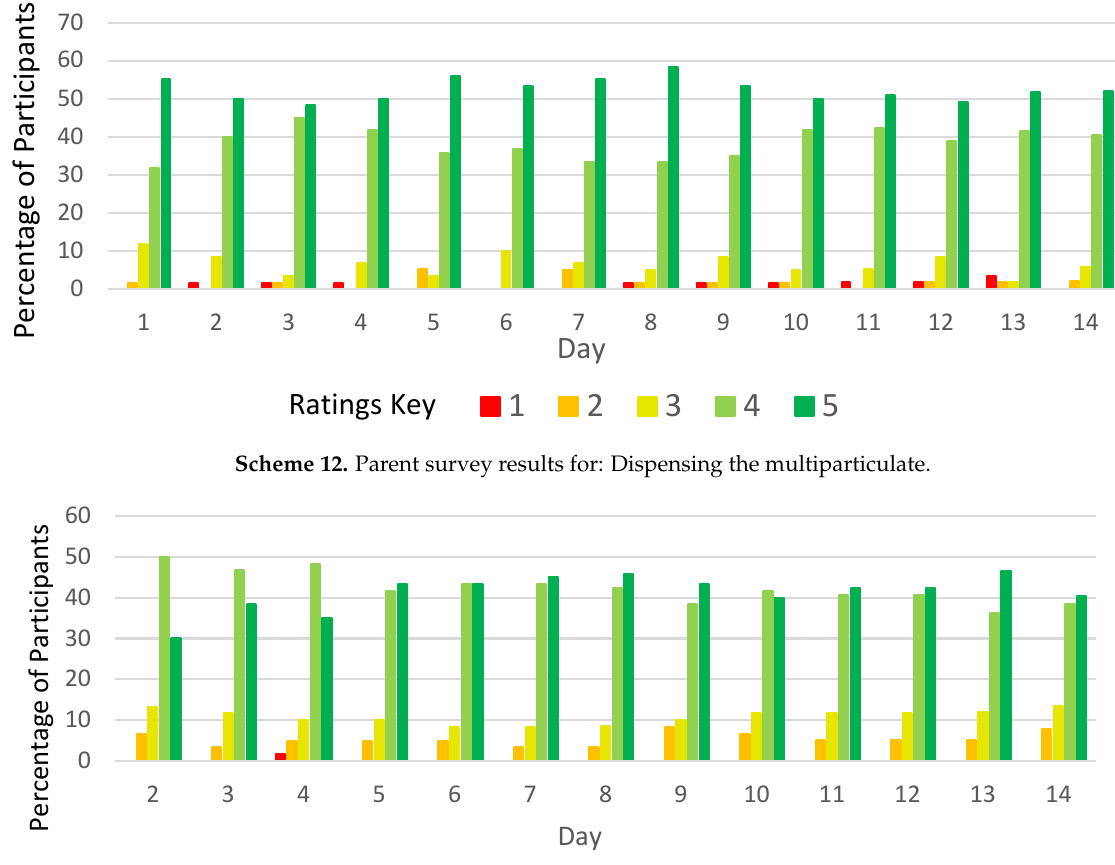
12 of 18 Scheme 11. Parent survey results for: Connecting the syringe . ( A ) ( B ) Figure 4. Picture of a broken plunger tops. ( A ) Participant used excessive force while pressing the plunger rod. ( B ) Broken when the participant exerted a lateral force of the plunger rod, snapping off the top of it. 3.2.4. Dispensing the Multiparticulate Dispensing the MP was rated very highly among parents (Scheme 12). The minimal low ratings were associated with issues involving moisture getting into the bottle, the plunger rod becoming difficult to push, MP spilling out of the bottle, and having to tap the bottle excessively to get the MP out. The most common of these issues was the mois- ture getting into the bottle. The instructions that the participants received can be viewed in Appendix B. Please refer to Figure A1C, steps 16–18 for the proper way to clean the